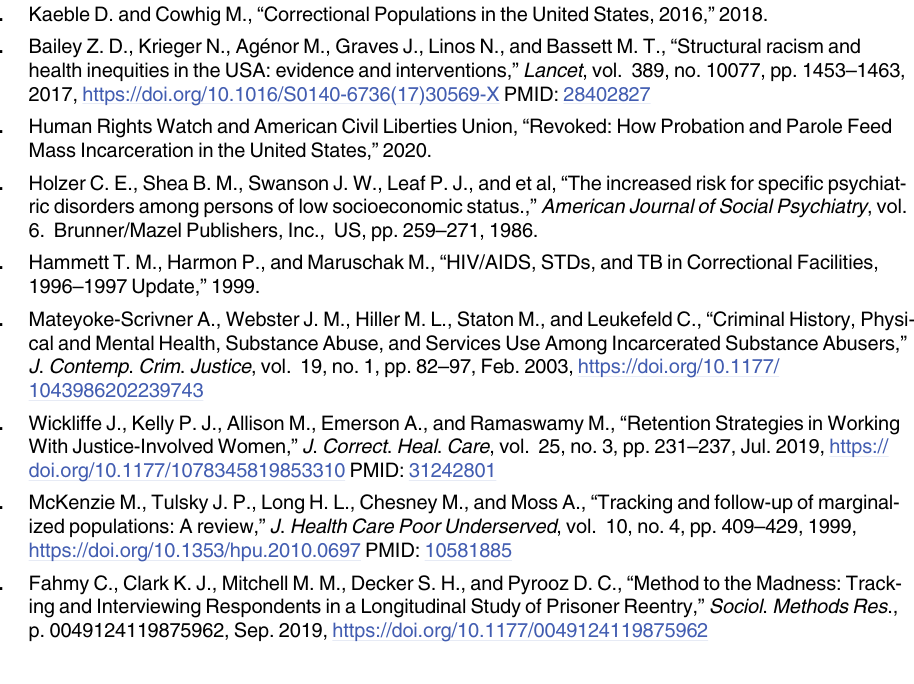
S2 Table. Demographics of participants who completed the 18-month (N = 180) and